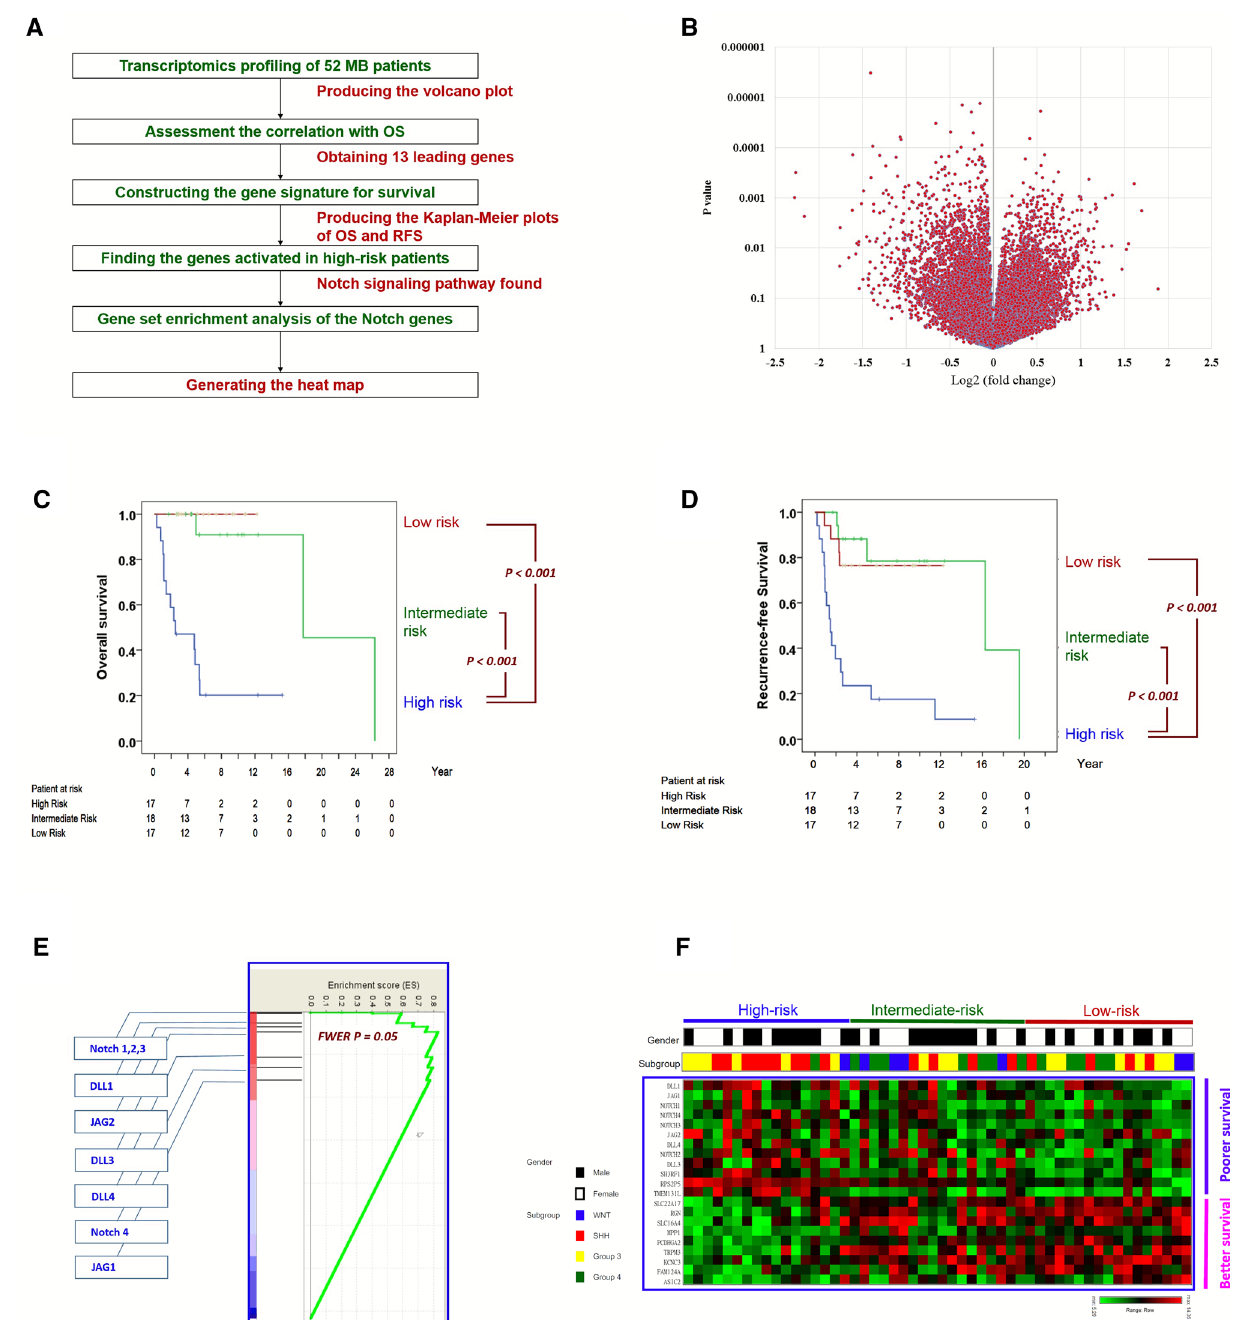
Figure 1. Derivation of a gene-signature based patient stratification score and identification of Notch activation in high-risk patients. ( A ) the flow chart; ( B ) the volcano plot of transcriptome-wise expression comparison of patients deceased and not deceased during the follow up; ( C ) the overall survival of patients stratified by the gene-signature based score; ( D ) the recurrence-free survival of patients stratified by the score. P values in the Kaplan–Meier plots were calculated by the log-rank test; ( E ) genes in the Notch pathway are at the leading edge of the rank of differentially expressed genes (the enrichment score = 0.83); ( F ) the heat map of gene levels in the 52 patients sorted by their gene-signature